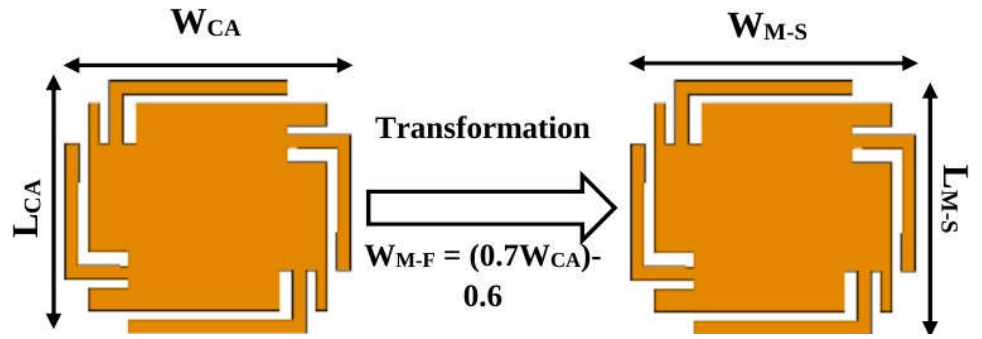
Figure 14. Transformation process of the patch dimensions at Step 2 of the design process.